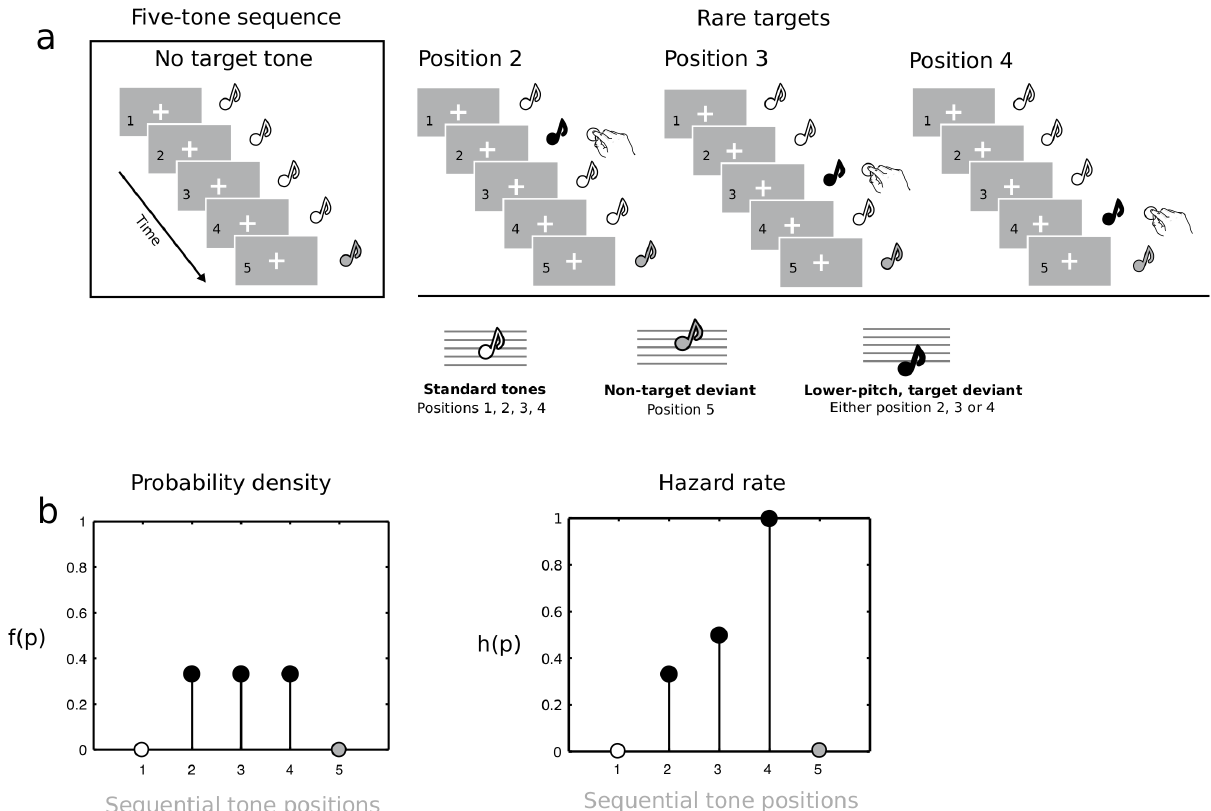
Fig 1. Experimental design. A: Continuously repeating five-tone sequences (left panel, four A 4 tones followed by a B 4 tone) were rarely (20% of the times) interspersed with sequences containing a target tone (F 4 ) at either of three, equally probable, positions (position 2, 3, and 4, right panel). Elapsed time refers to within-sequence effects of target onset at positions 2, 3 or 4. B: Left, the ensuing discrete probability density function: all potential target onset positions have the same probability. Right, the resulting hazard rate model. The first standard tone and the last non-target tone never hosted a